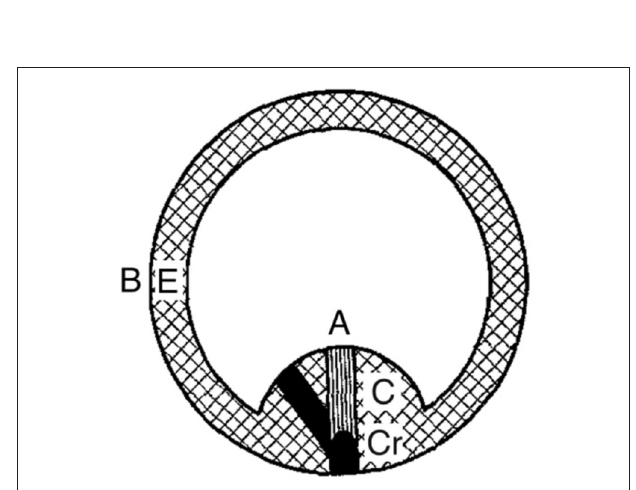
FIGURE 2 | Semicircular canal with ampulla and cupula